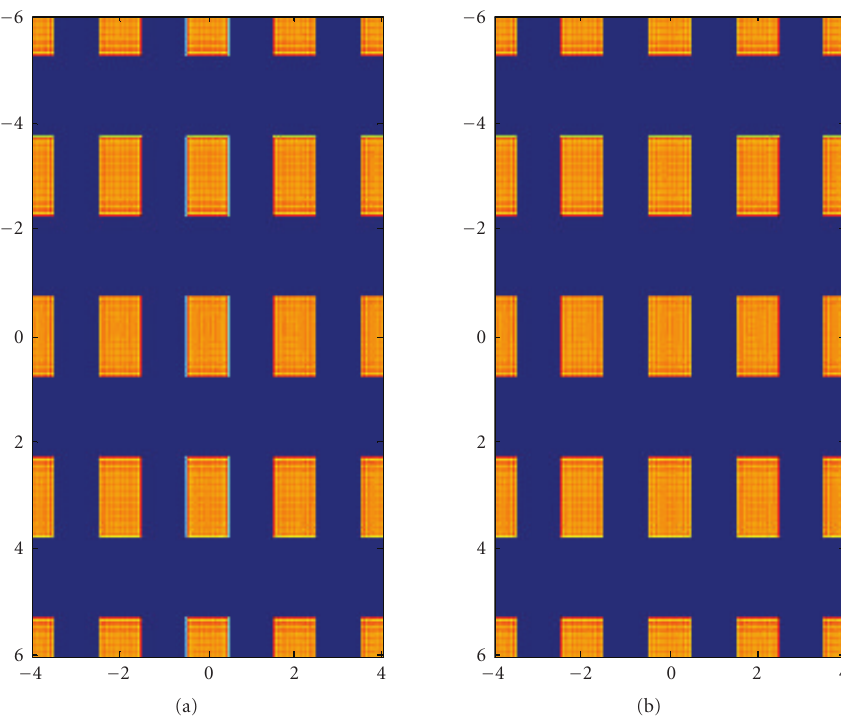
Figure 2: Intensity distribution for an incident coherent plane wave of energy of 40keV behind the grating G1 of periods p x = 2 μ m and p y = 3 μ m. The grating transmission function is assumed to be a Ronchi grating. The Talbot distance is Z T = 232cm . (a) The distribution of the grating transmission function. (b) The distribution of the wave intensity at the Talbot distance. The spatial unit is μ